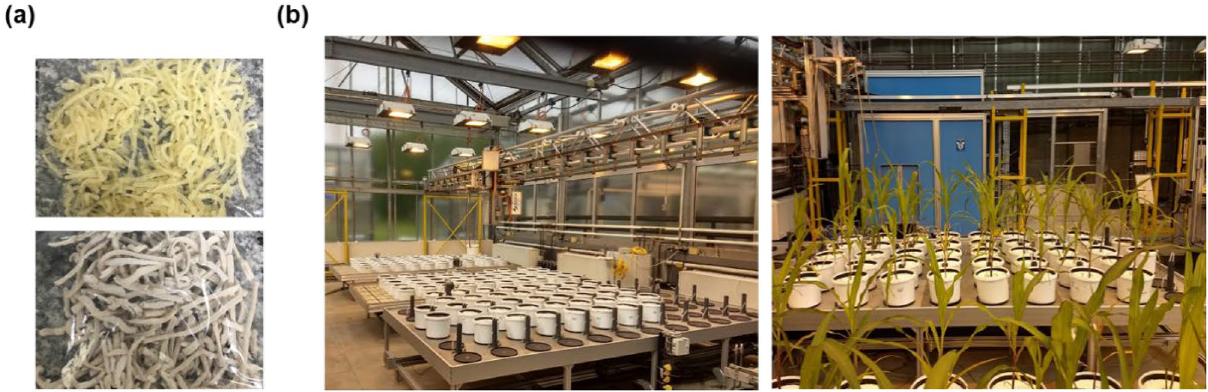
Figure 8. ( a ) Pure thermoplastic starch (top) and 75St-TPS composites (bottom), before grinding into smaller pieces. ( b ) The greenhouse experiment setup at the beginning of cultivation (left) and by the end